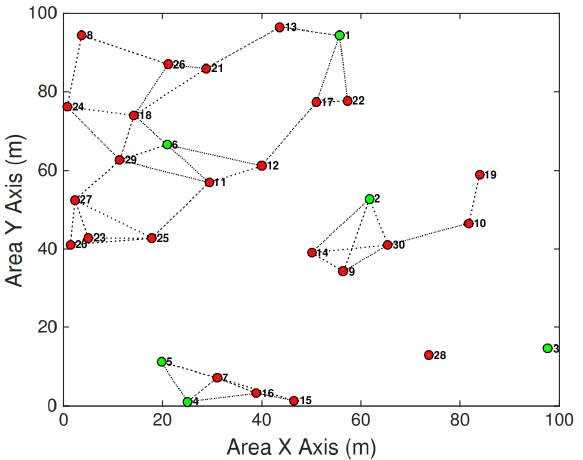
Figure 6. An example sparse network topology consists of six beacons and 24 unknown nodes.